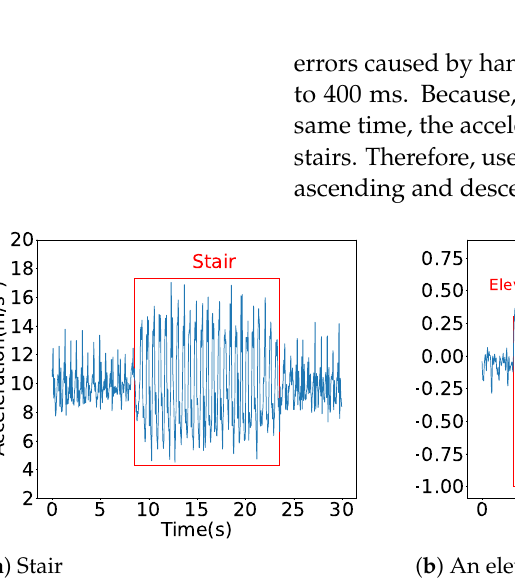
Figure 5. Variations of acceleration. ( a ) represents the change of acceleration data at the stair. ( b ) represents the change of acceleration data when an elevator rises. ( c ) represents the change of acceleration data when an elevator